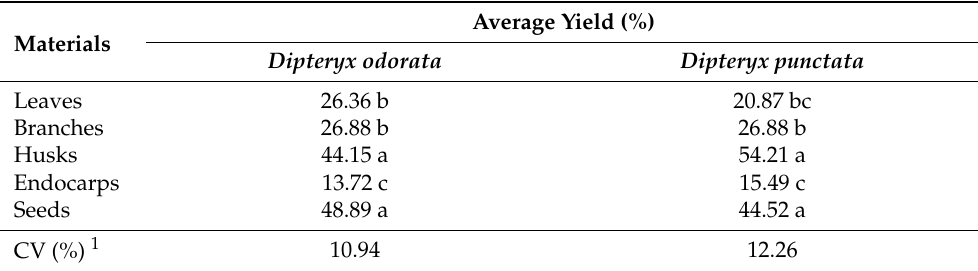
Table 1. Average yield of the ethanolic extracts obtained via Soxhlet of different parts of Dipteryx odorata and Dipteryx punctata .